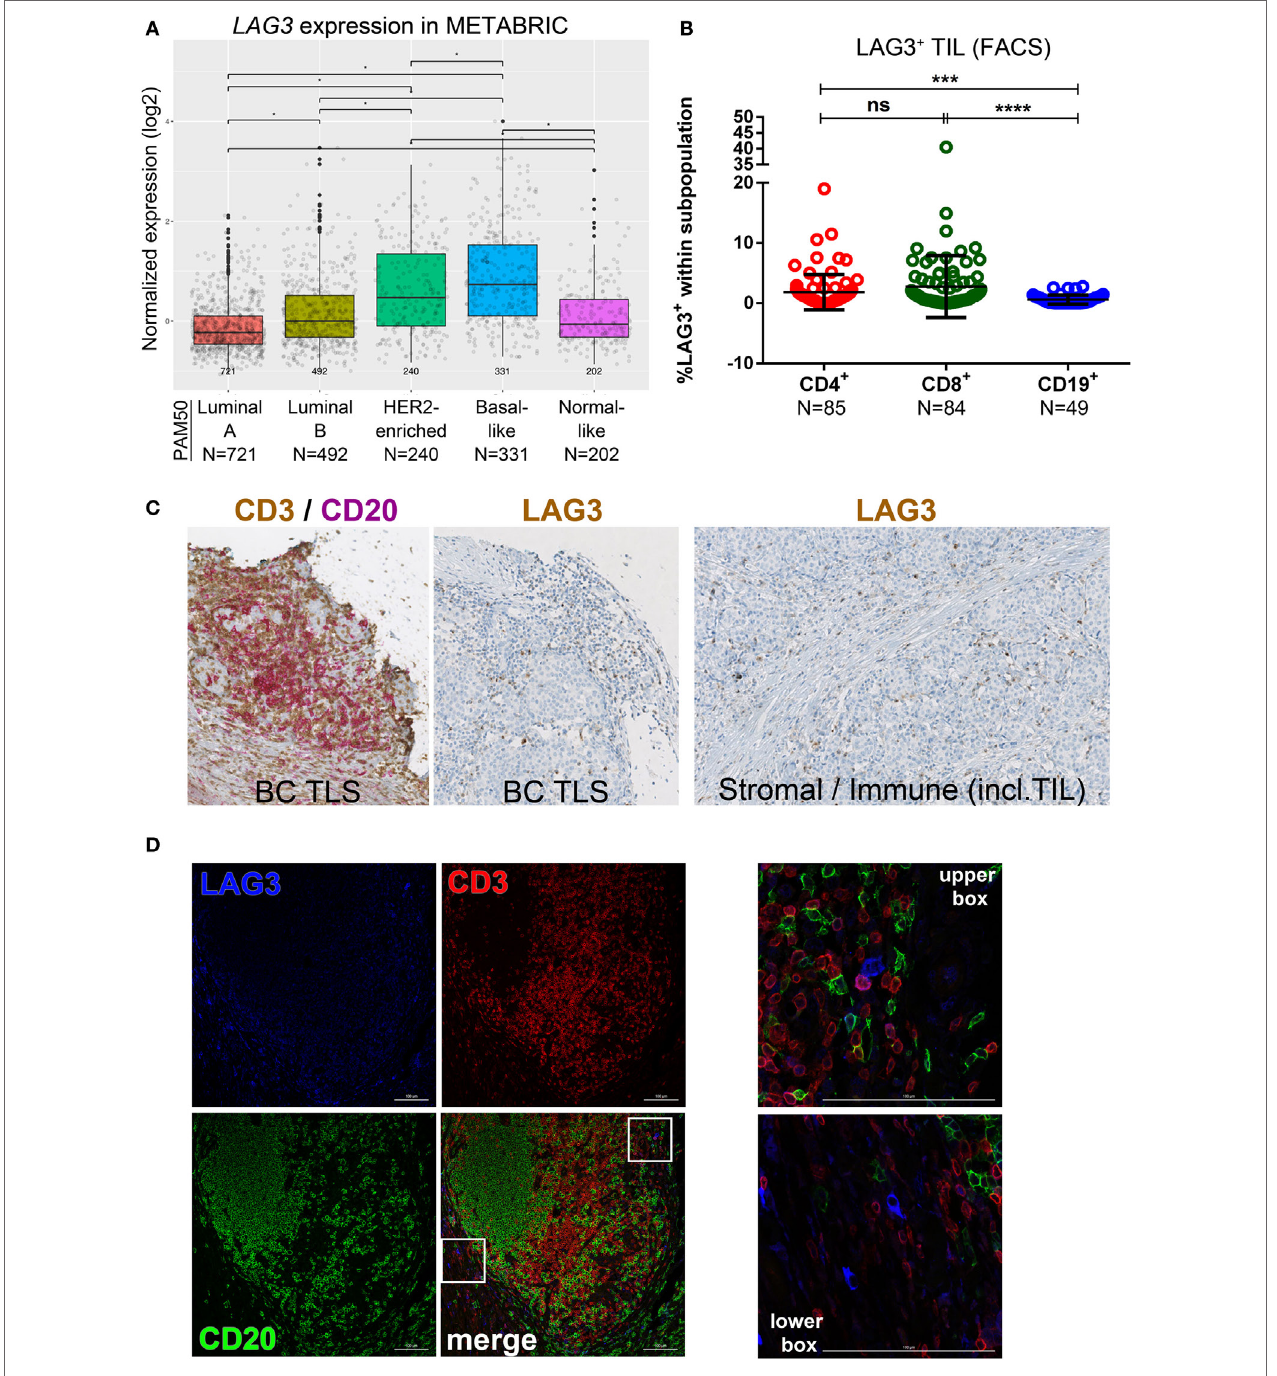
FigUre 5 | Expression of LAG3 in primary breast cancer (BC). (a) Expression of LAG3 gene by PAM50 molecular subtypes (microarray data from the METABRIC dataset) (37). Box plots show median ± interquartile range related to log of expression of LAG3 gene in different subtypes (Luminal A, Luminal B, HER2-enriched, Basal-like, and Normal-like). (B) LAG3 expression by the major subsets (CD4 + , CD8 + , and CD19 + ) of tumor-infiltrating lymphocytes (TIL) isolated from fresh primary breast tumors analyzed by FACS. Bars show mean ± SD. The number of samples included ( N ) is based on the tumor homogenate having a threshold minimum number of TIL for analysis. (c) LAG3 expression in BC-associated tertiary lymphoid structures (TLS) by immunohistochemistry (IHC). A representative example of a TLS stained with the dual CD3/CD20 and with the LAG3 IHC stain. In brown: CD3 and LAG3; in red: CD20. LAG3 was also found expressed by immune cells including TIL and plasmocytes localized in the stroma or in intratumoral areas and by stromal cells (i.e., fibroblasts, etc.). (D) Immunofluorescence staining of a BC associated TLS with LAG3 (in blue), CD3 (in red), and CD20 (in green). In the upper box: LAG3 + CD3 + TIL; in the lower box: non-lymphoid LAG3 + cells.